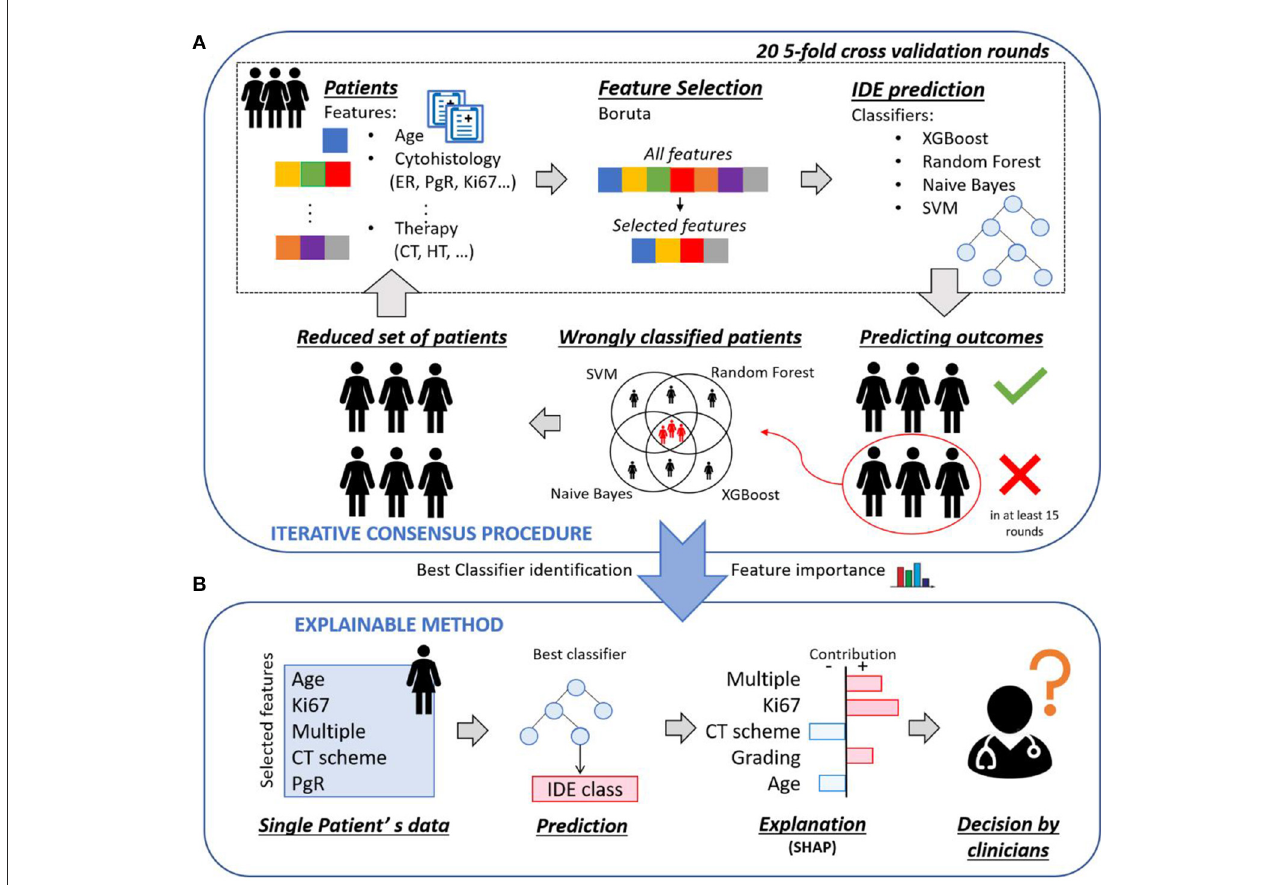
FIGURE1 Overview of the proposed explainable framework for both 5-year and 10-year IDE prediction. (A) An iterative consensus procedure is used to define a reliable base of knowledge: first, a subset of features, that were relevant for the prediction outcome, were selected by means of Boruta technique; then, the IDE prediction were evaluated by means of four classifiers. The patients misclassified by all the four classifiers were identified and considered as confounding patients. (B) An explainable analysis determines individual patient classifications and outlines how features contributed to the decision of the model through the computation of Shapley